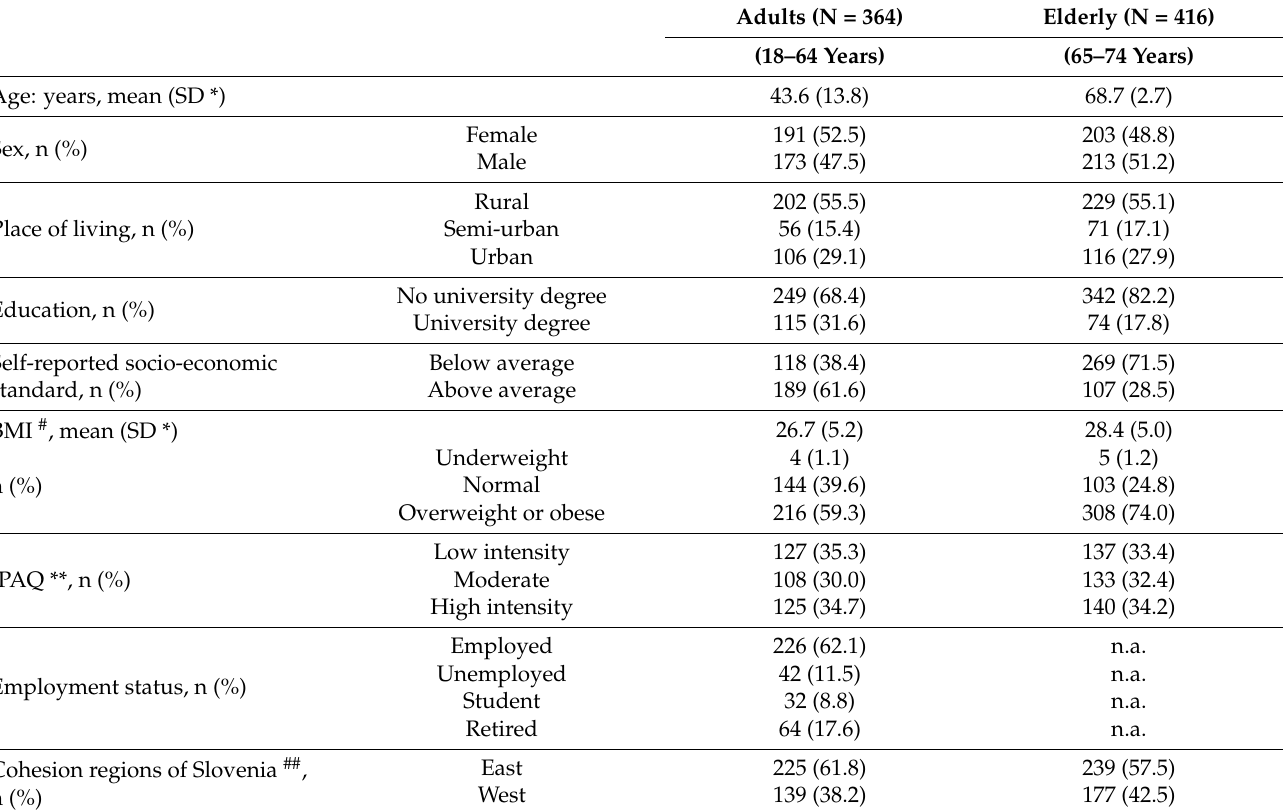
Table 1. Characteristics of adult and elderly participants in the Slovenian national dietary survey SI.Menu 2017/18 (N =